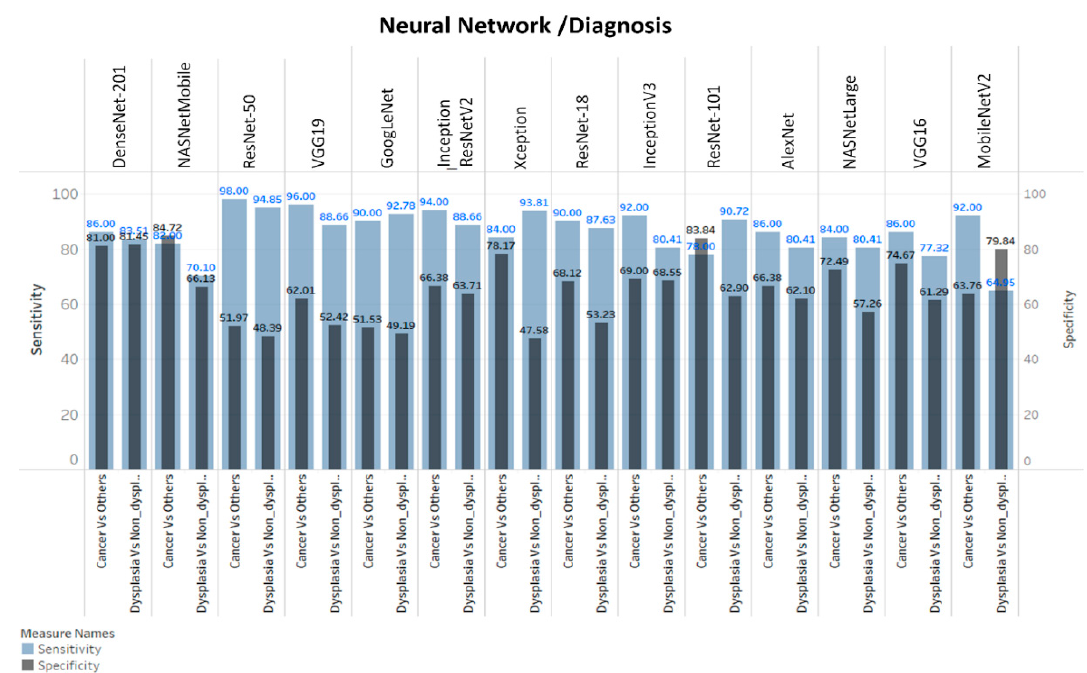
Figure 6. Sensitivity and specificity of neural networks. DenseNet ‐ 201 and NASNetMobile showed best sensitivity/specificity in delineating cancer vs others whereas DenseNet ‐ 201 was best in differentiating dysplasia vs non ‐ dysplasia lesions.